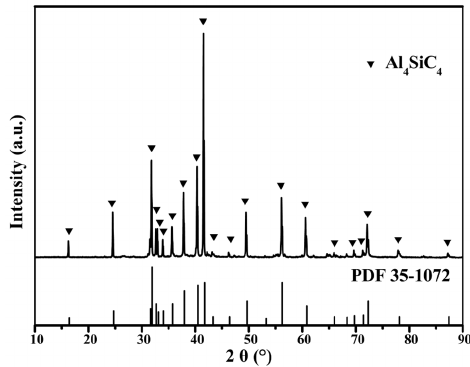
Figure 1. XRD pattern of Al 4 SiC 4 powders and corresponding standard spectral line.